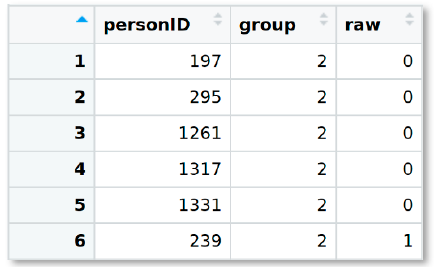
Figure 2. Structure of the included ELFE data set.